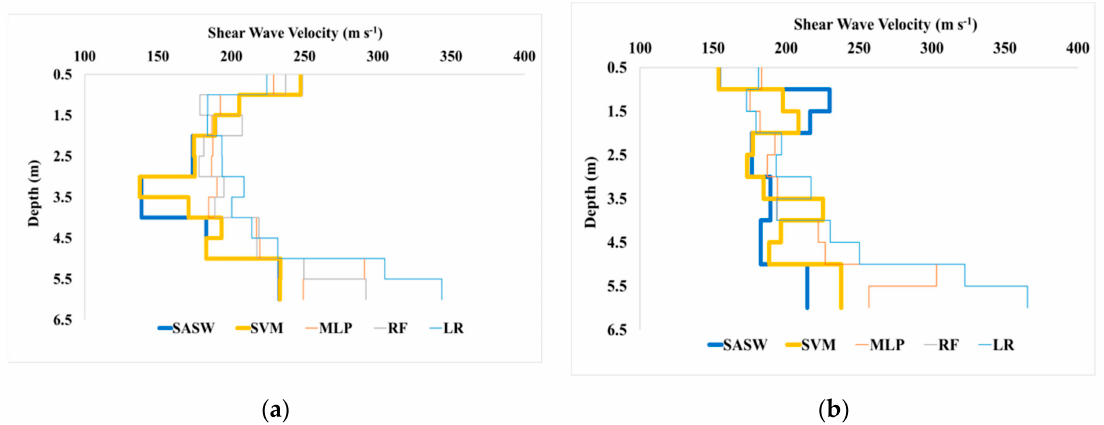
Figure 17. V S profiles from SASW and ML algorithms for ( a ) test 9 and ( b ) test